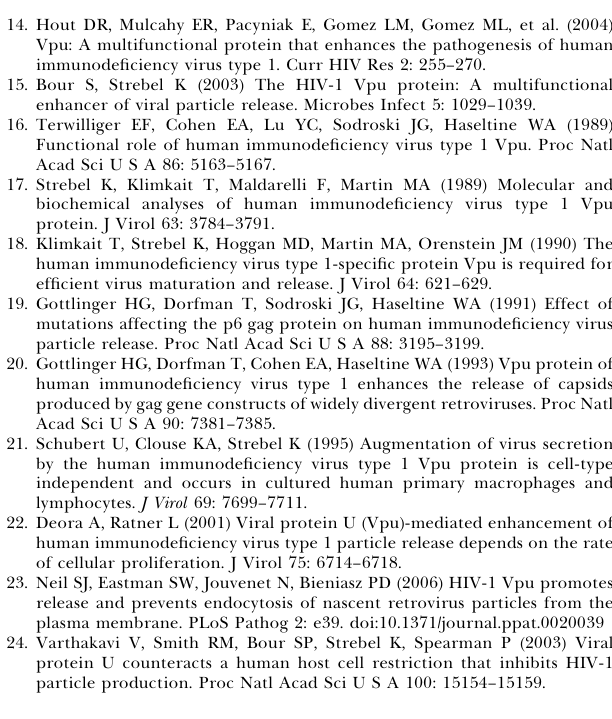
Figure S2. Vpu-HA-GFP Is Not Detected in Mitotic Cells